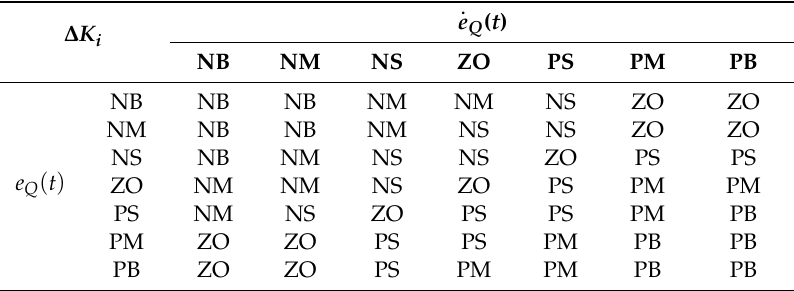
Table 2. Fuzzy control rules for ∆ K i .